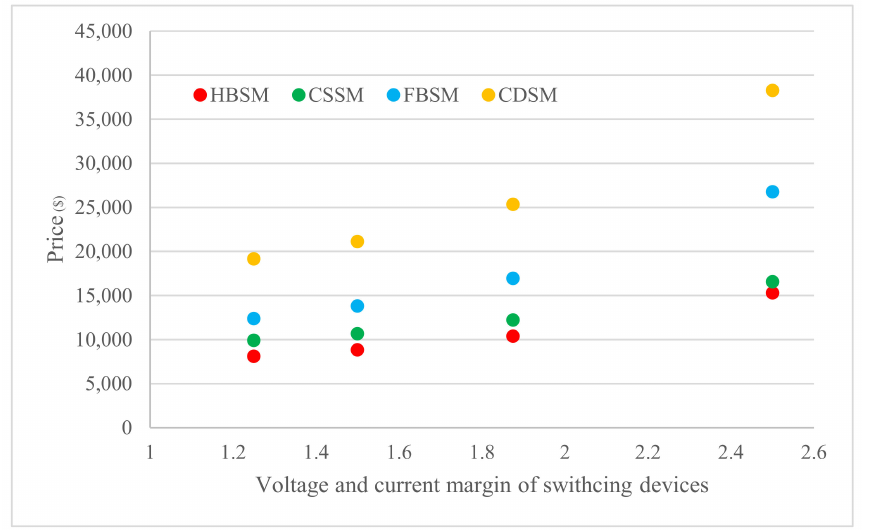
Figure 16. Price of submodules according to voltage and current margin of the switching